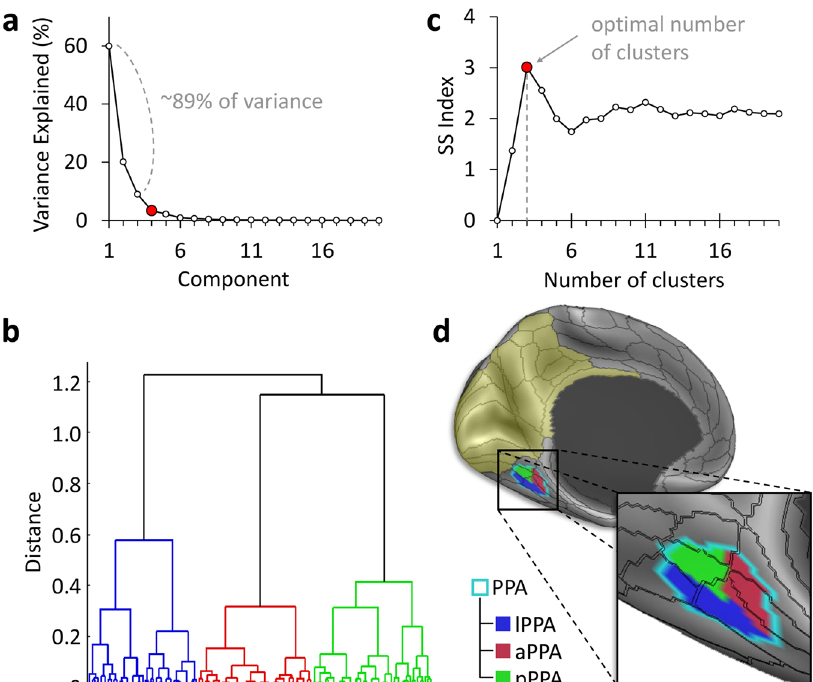
Fig. 2 Clustering analysis of the PPA reveals multiple anatomical subunits. Data-driven clustering of the parahippocampal place area (PPA) based on average structural connectivity in 200 subjects. a Principal component analysis (PCA) based on the PPA ’ s connectivity to a region encompassing early visual cortex (EVC), the retrosplenial complex (RSC), and medial parietal cortex (MPC) (yellow tint) resulted in three principal components. b Hierarchical agglomerative clustering grouped PPA surface vertices with similar PCA coef fi cients. c The highest separation vs. spread (SS) index 38 objectively determined the optimal number of clusters. d The resulting anterior, posterior, and lateral PPA clusters are shown on the in fl ated brain surface.